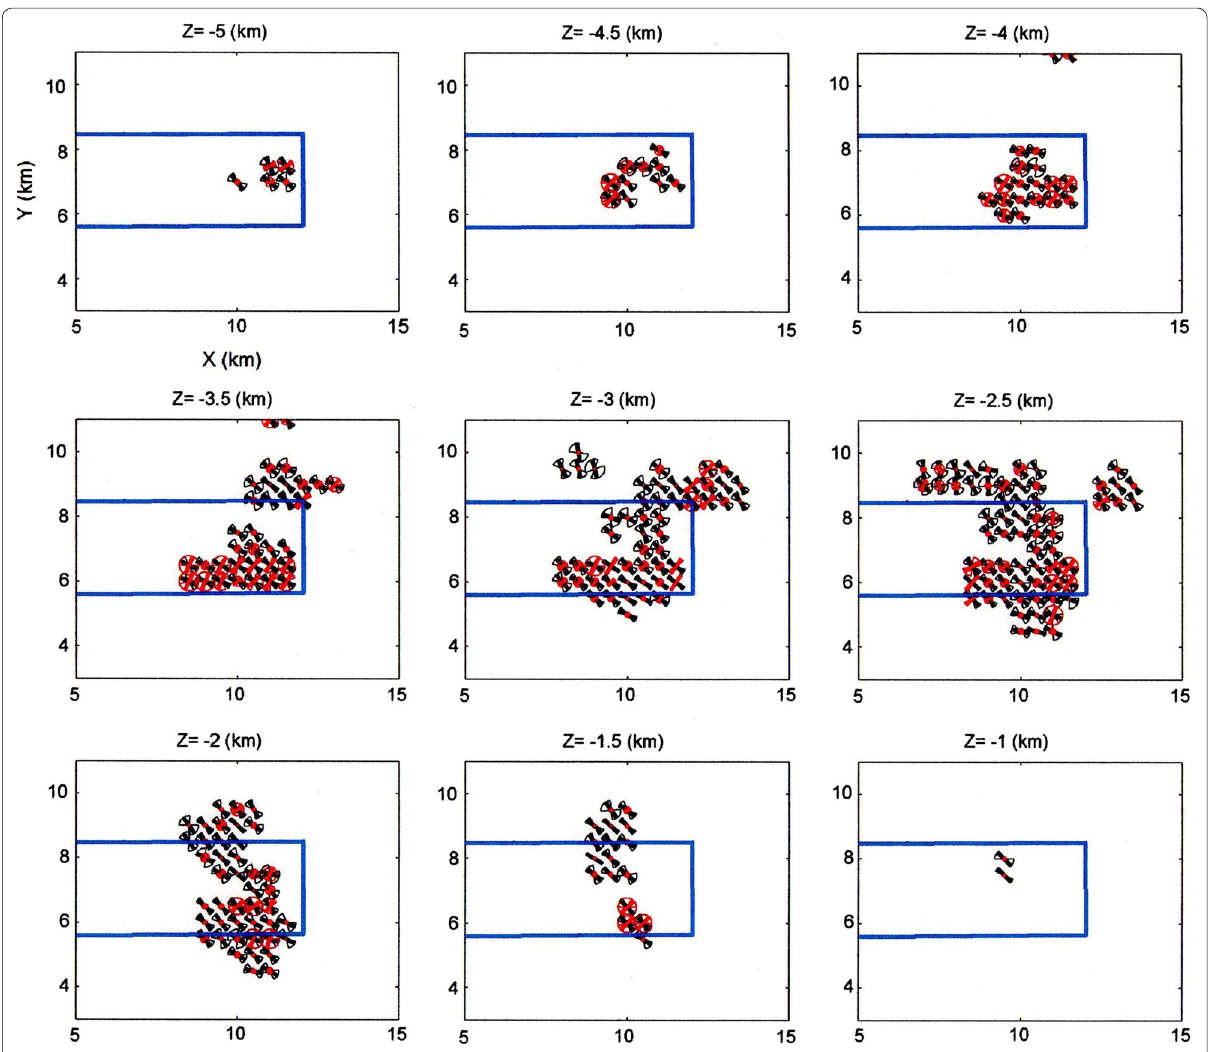
Fig. 7 95% confidence limits of the σ 1 and σ 3 axes are indicated by black and red fans, respectively. Other explanations are the same as for Fig.